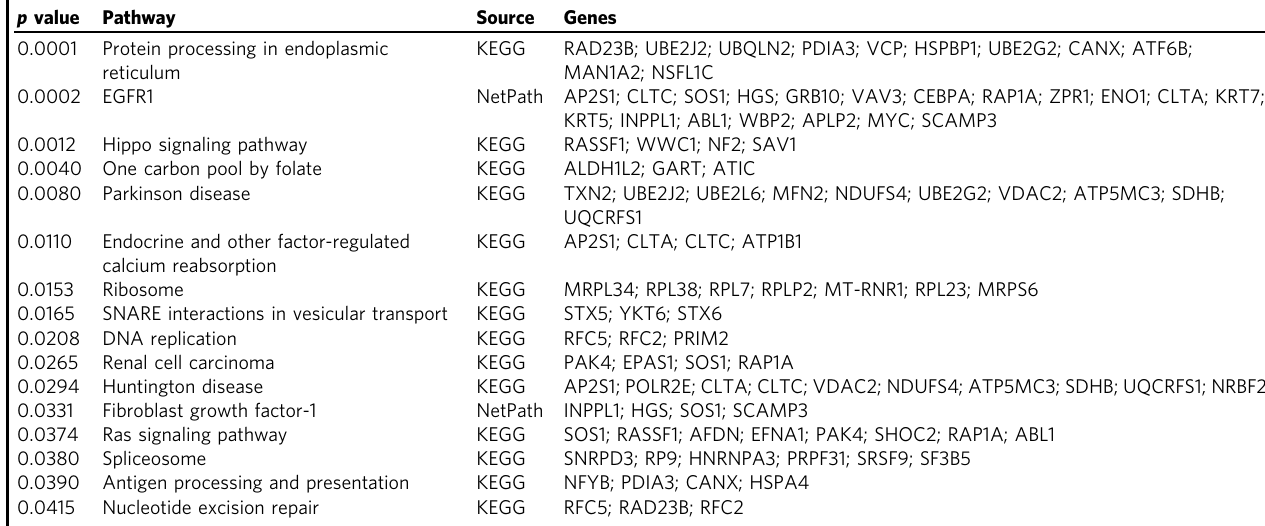
Table 1 Pathway enrichment analysis of the 321 circ_0076611-interacting mRNAs identi fi ed by ChIRP-RNAseq in MDA-MB-468 cells performed by interrogating the ConsensusPathDB tool (http://cpdb.molgen.mpg.de) ( p < 0.05, N ≥